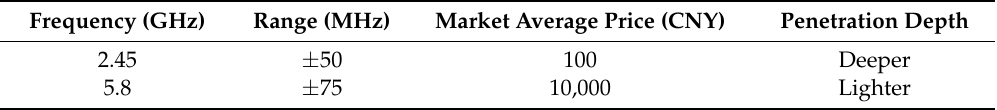
Table 6. Comparison of different microwave frequency prices.